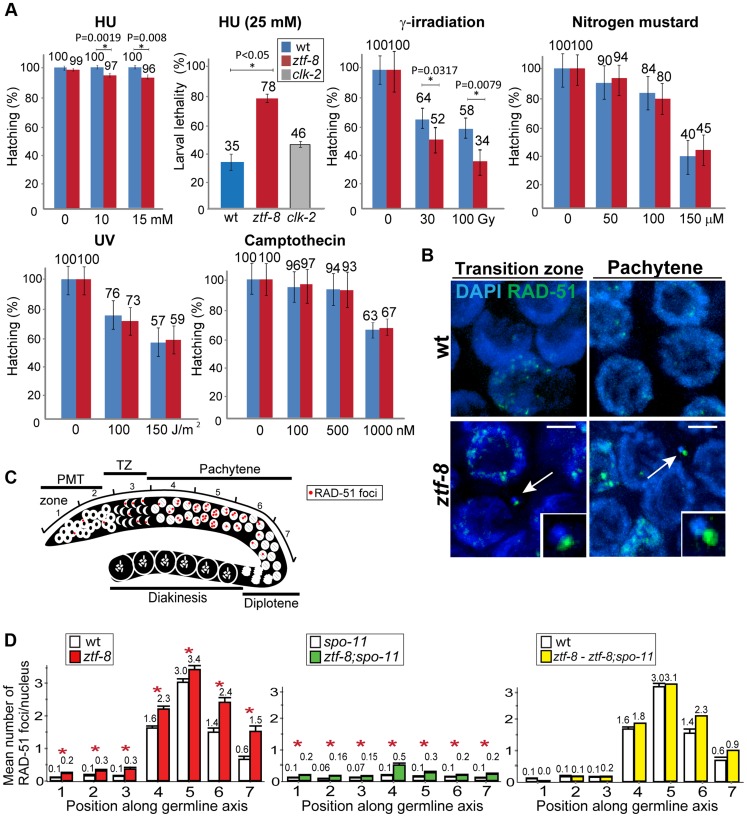
ZTF-8 is required for DNA repair in both mitotic and meiotic germline nuclei.
A. Relative hatching or larval lethality of wild type, ztf-8 and clk-2 mutants after treatment with the indicated doses of hydroxyurea (HU), γ-irradiation, nitrogen mustard, UV and camptothecin. Asterisks indicate statistical significance; P values calculated by the two-tailed Mann-Whitney test, 95% C.I. B. IR-induced chromosome defects in the absence of ztf-8. Shown are representative images of nuclei at leptotene/zygotene (transition zone) and pachytene stages from wild type and ztf-8 worms 18 hrs after γ-IR exposure (40 Gy). Chromosome fragments are indicated by arrows and depicted at higher magnification in the insets. Chromosome fragments were observed at the following frequencies: wt: 0/20 and ztf-8 mutants: 6/20 gonads. Bars, 2 µm. C. Diagram of a C. elegans germline indicating the position of the zones scored for RAD-51 foci. D. Mean number of RAD-51 foci per nucleus. Histograms represent the quantitation of RAD-51 foci in germlines of the indicated genotypes. Quantitative analysis of RAD-51 foci depicted in Figure S4 is represented here as the mean number of RAD-51 foci observed per nucleus (y-axis) on each zone along the germline axis (x-axis) for indicated genotypes. To identify the levels of meiotic RAD-51 foci, mean number of RAD-51 foci at each zone in ztf-8;spo-11 mutants was subtracted from ztf-8 mutants. Error bars represent standard error of the mean. Asterisks indicate statistical significance.